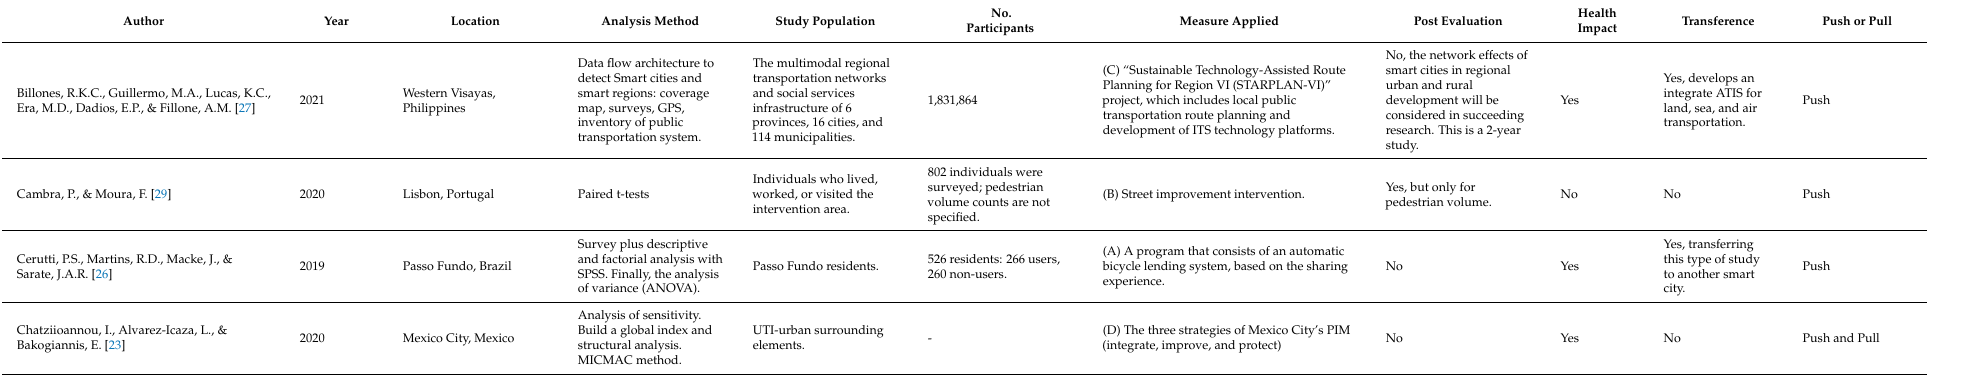
Table A3. Analysis of the scoping review